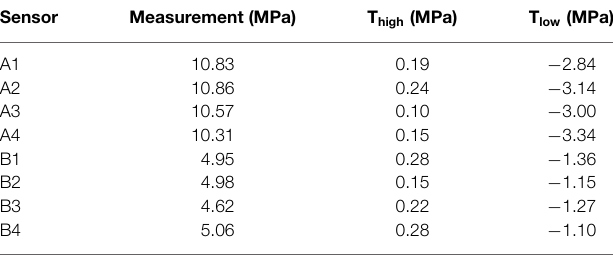
TABLE 4 | Equivalent stress ranges at measurement locations and falsification thresholds for EDMF. Sensor